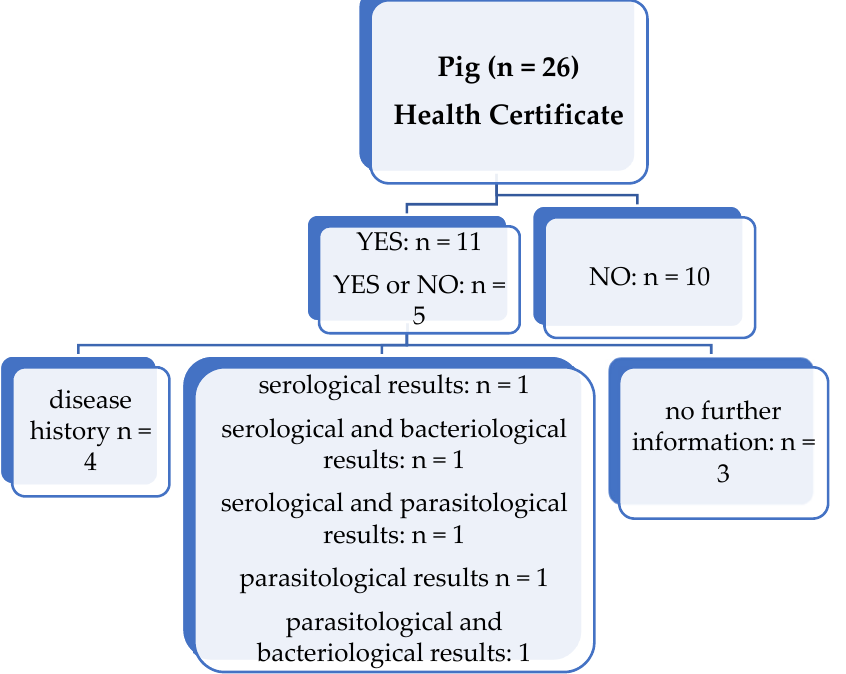
Figure 3. Overview of whether pigs were purchased with or without a health certificate and which information was provided in the health certificate. Two participants did not answer the question. n = number of responding participants; yes/no: Testing was/was not performed.